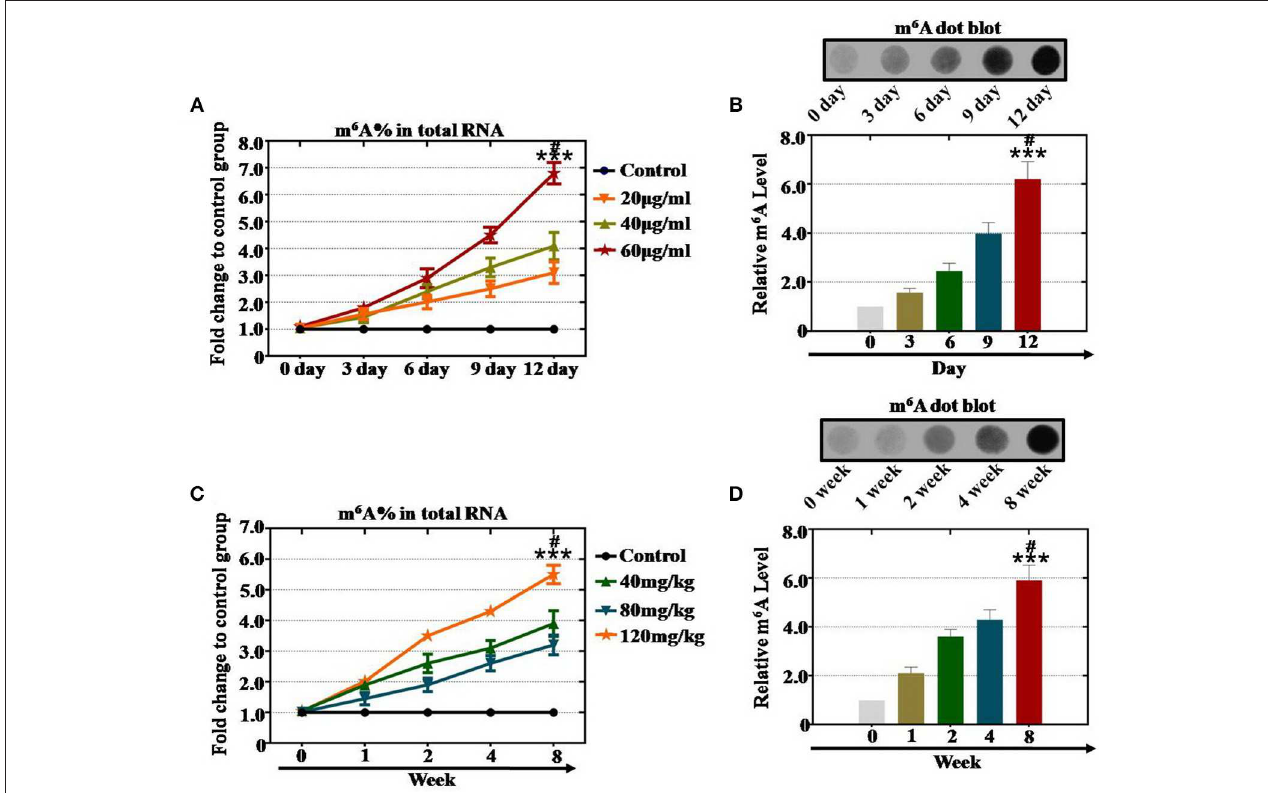
FIGURE 1 | Quantification and statistical analysis of the m 6 A expression levels after CTX treatment in vivo and in vitro . (A) The m 6 A content was tested in hGCs by a m 6 A test kit after treatment with 20, 40, and 60 µ g/ml CTX from 0 to 12 days. (B) The dot blot method tested the m 6 A levels in hGCs after treatment with 60 µ g/ml CTX from 0 to 12 days. (C) The m 6 A content was tested in mouse ovaries by a m 6 A test kit after treatment with 40, 80, and 120 mg/kg CTX from 0 to 8 weeks. (D) The dot blot method detected the m 6 A levels in mouse ovaries after treatment with 40, 80, and 120 mg/kg CTX from 0 to 8 weeks. All experiments were performed three times. The error bars indicate SD; *** p < 0.001 (compared with the 0 day or 0 week group); # p < 0.05 (compared with 9 days or 4 weeks in same CTX concentration group).